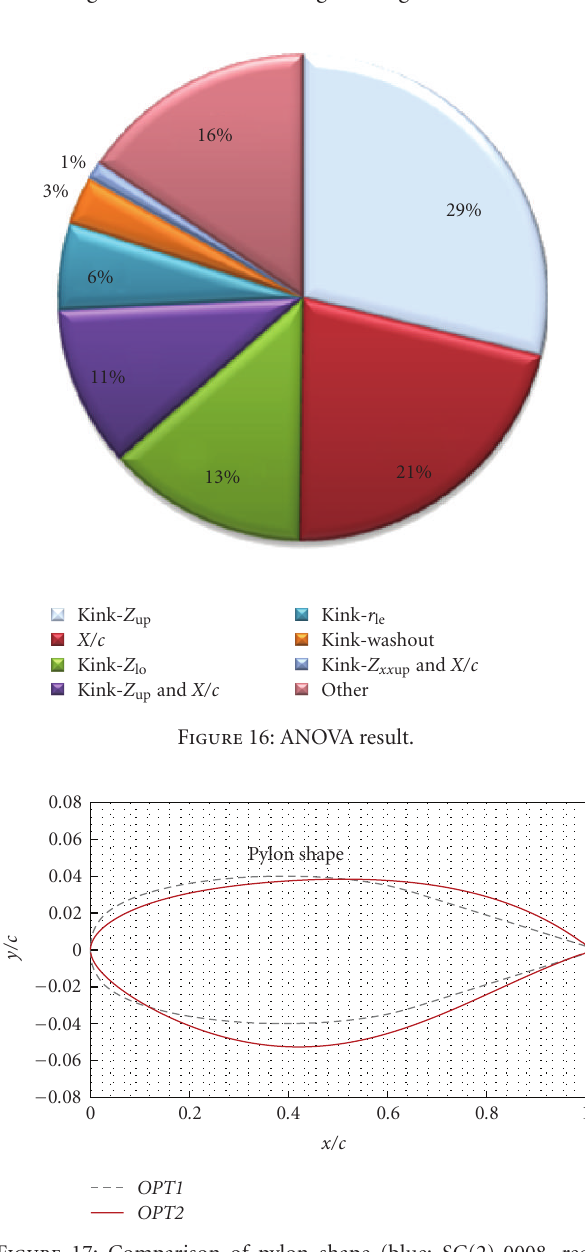
Figure 17: Comparison of pylon shape (blue: SC(2)-0008, red: OPT2 ).